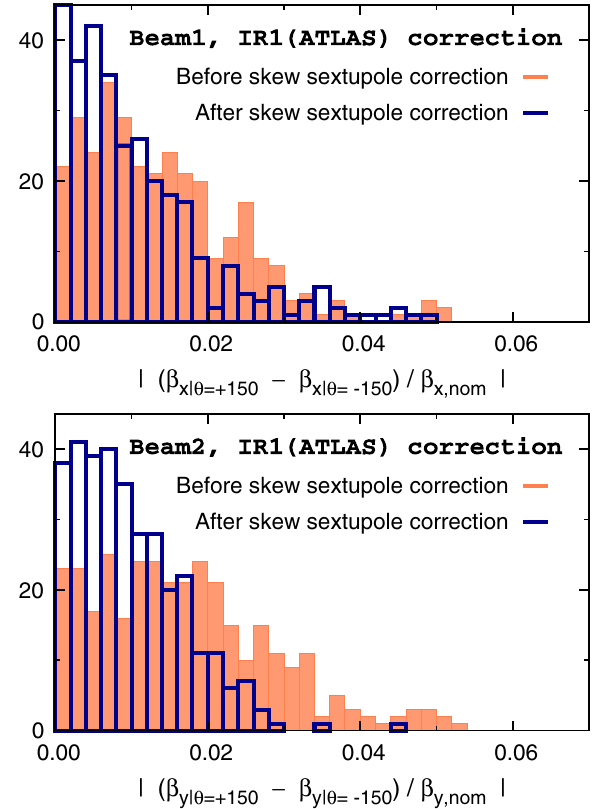
FIG. 23. Histograms of beta-beating measured at LHC BPMs, before (blue) and after (red) skew sextupole compensation in IR1 (ATLAS).